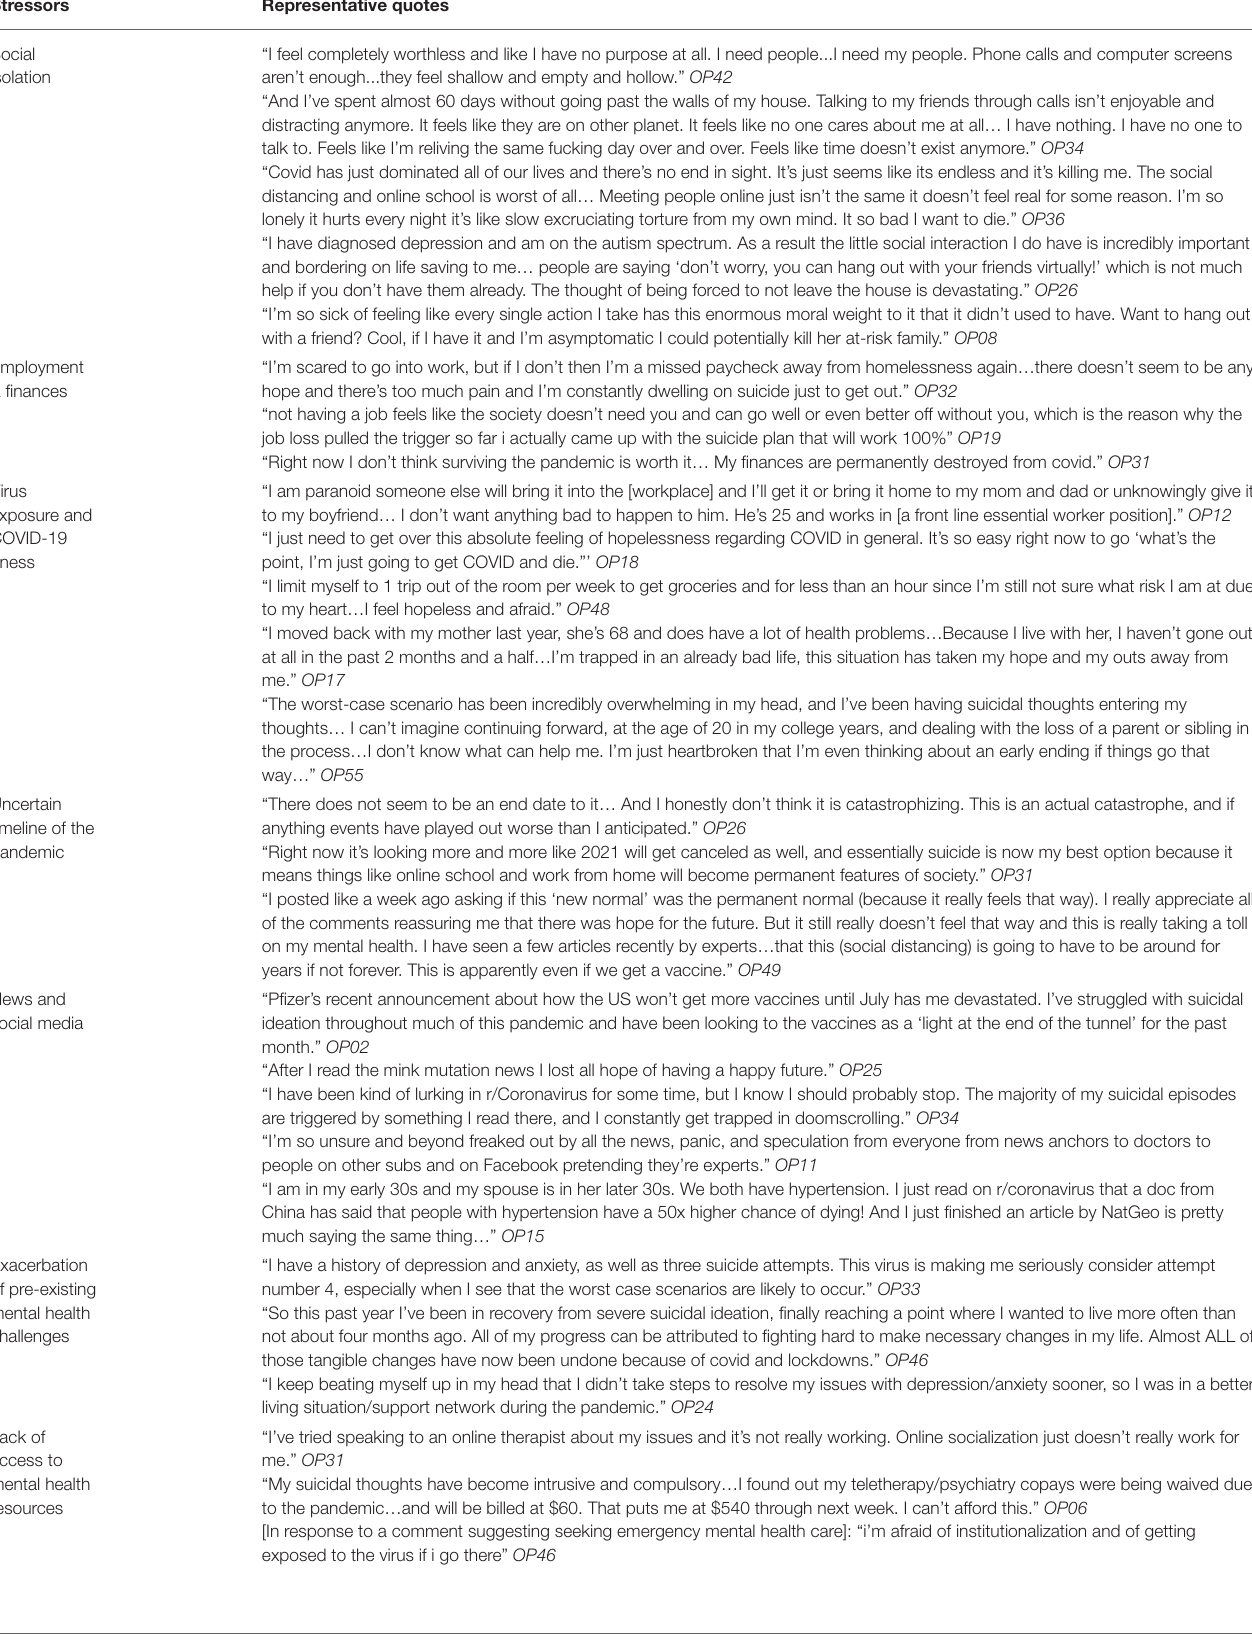
TABLE 1 | Pandemic stressors shaping r/COVID19_support Reddit users’ experiences of suicidal thoughts.